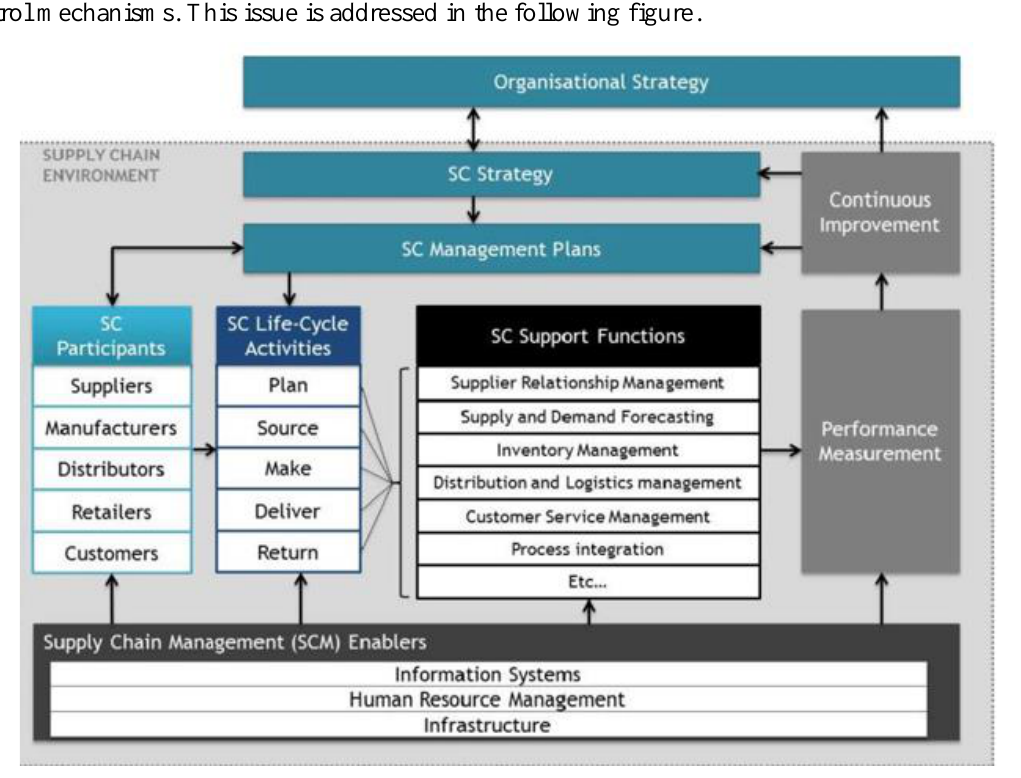
Figure 3. A Framework of Key Supply Chain Activities